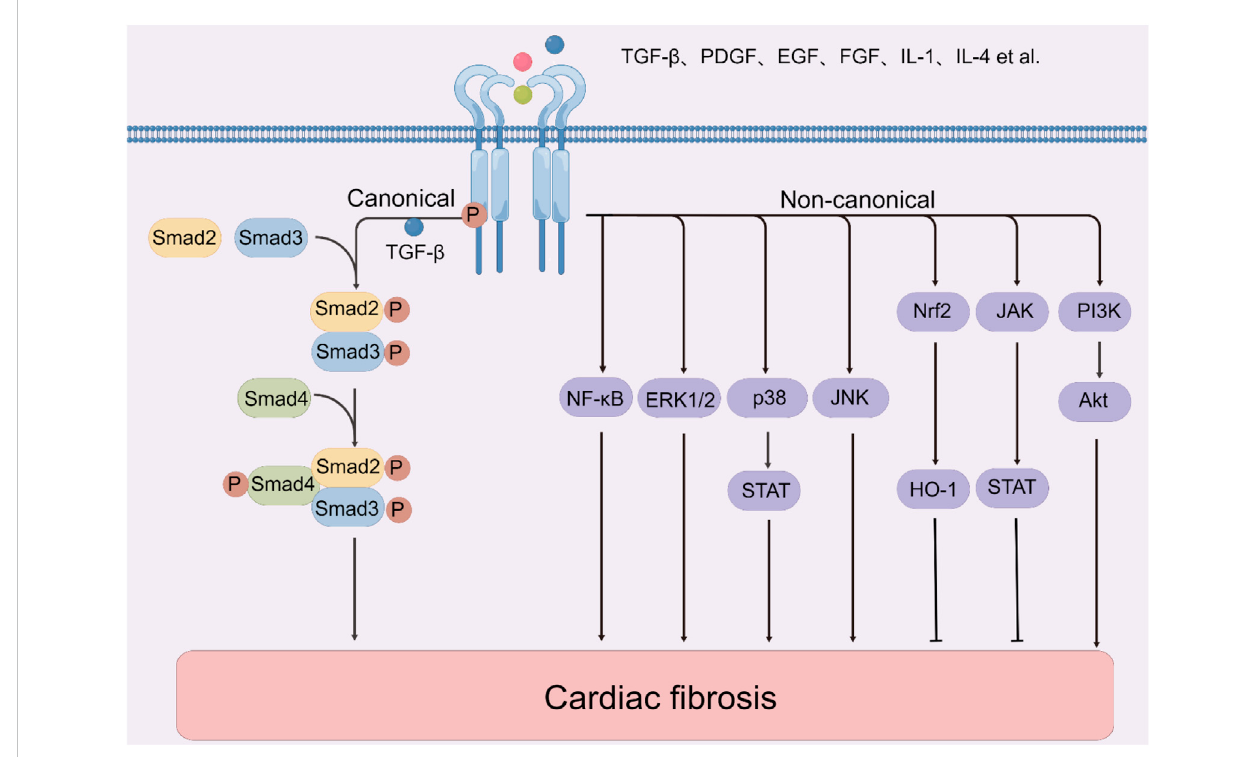
FIGURE 1 Themolecularmechanismsofcardiac fi brosis. Note: Akt,proteinkinaseB;EGF, epidermalgrowth factor;ERK, extracellular signal-regulated kinase; FGF, fi broblast growth factor; HO-1, heme oxygenase-1; IL-1, interleukin-1; IL-4, interleukin-4; JAK, janus kinase; JNK, c-Jun N-terminal kinase; NF- κ B, nuclear factor kappa-B; PDGF, platelet-derived growth factor; PI3K, phosphatidylinositol 3-kinase; STAT, signal transducer and activator of transcription 3; TGF- β , transforming growth factor β